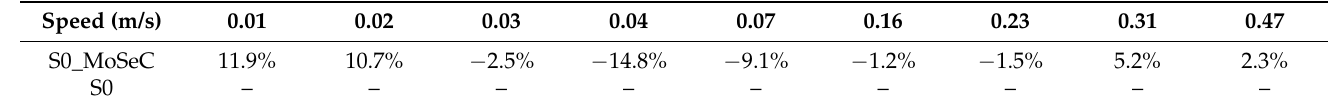
Table 6. Performance of the S0 and S0_MoSeC specimens (positive values are decreases in friction related to the smooth and uncoated specimen while negative values mean increases in friction). Figure 4. Stribeck curves for the S0 and S0_MoSeC specimens.